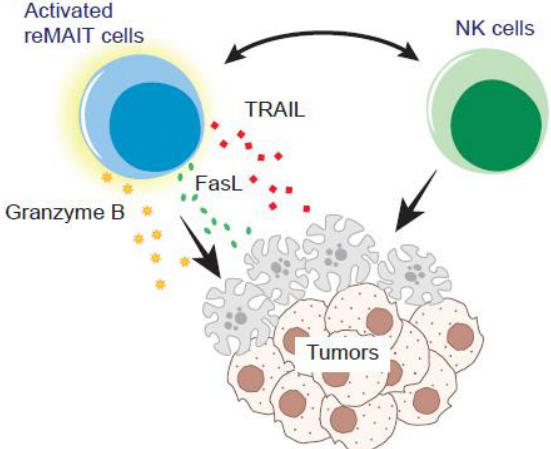
Figure 2. Tumor control by reMAIT cells. reMAIT cells (m-reMAIT cells and/or human iPSC-derived MAIT-like cells) could directly lyse the tumor cells and/or enhance the anti-tumor functions of NK cells. Interaction with NK cells induces Grzmb , Fasl , and Tnfsf10 , the effector molecules pertinent to exerting the cytotoxicity in reMAIT cells in vitro. NK cells and reMAIT cells synergistically enhance tumor-killing activity in vitro and likely in